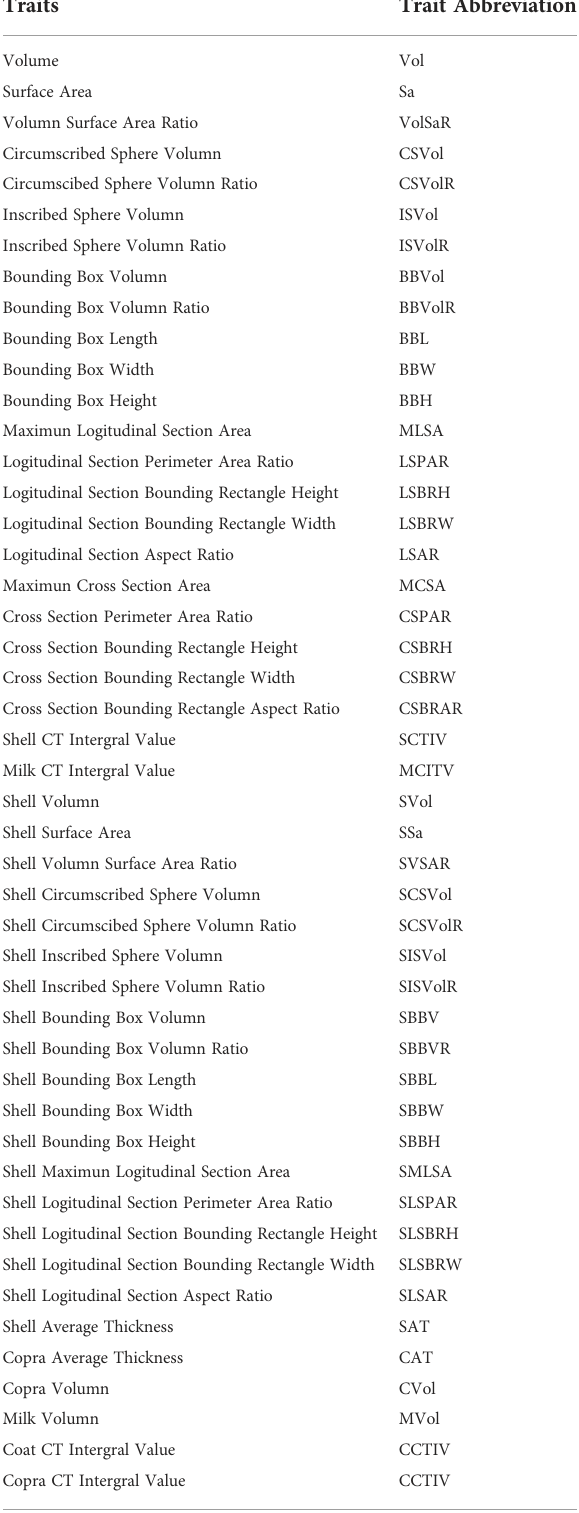
TABLE 2 The digital trait classi fi cation and